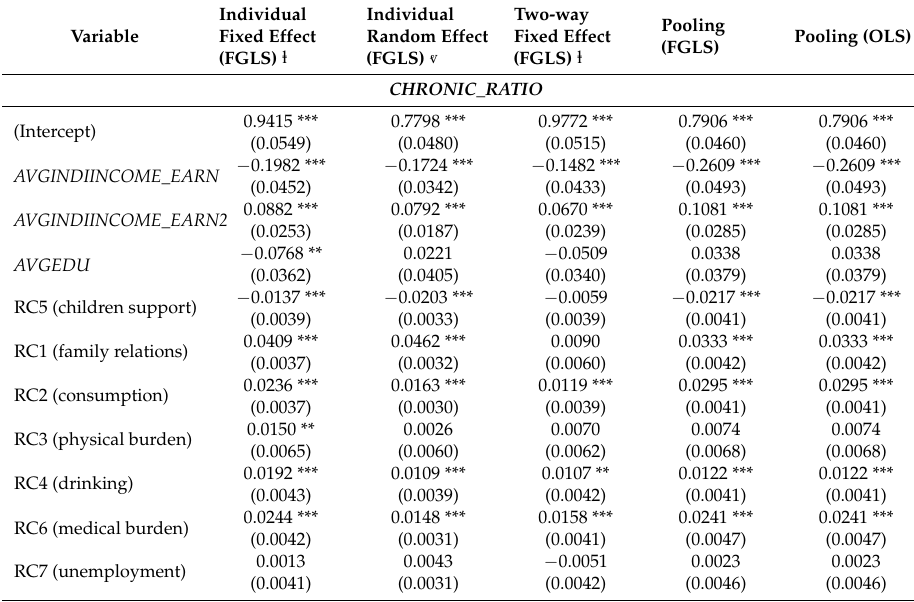
Table A8. Complete regression results (CHARLS).